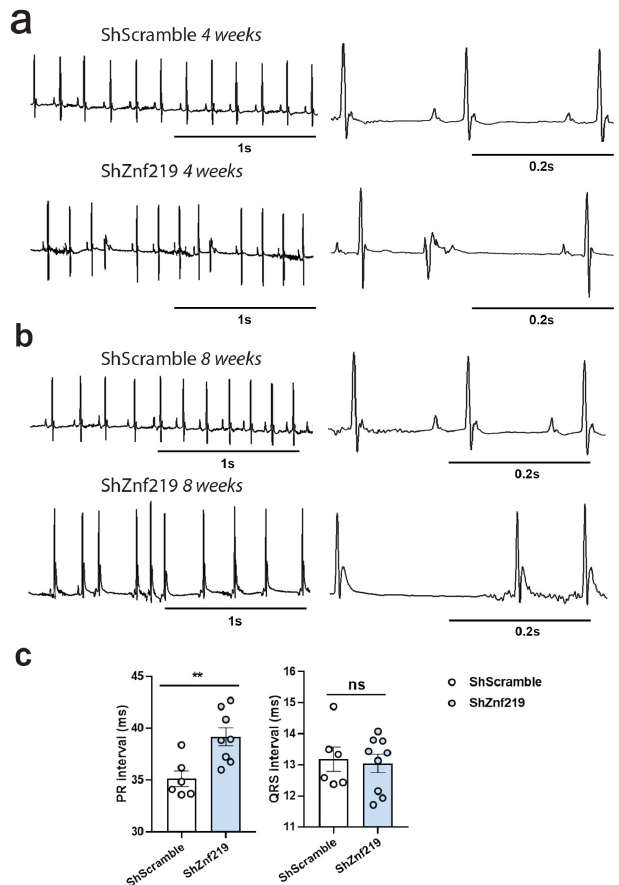
Figure 5. Znf219 knockdown induces cardiac arrhythmias . ( a ) Electrocardiography (ECG) traces of 4-week-old and ( b ) 8-week-old mice infected with shRNA-Scramble or shRNA- Znf219 , the latter showing arrhythmias ( c ). PR and QRS intervals in 4-week-old mice infected with shRNA-Scramble ( ShScramble ) or shRNA- Znf219 ( ShZnf219 )., ** p ≤ 0.01, (mean + S.E.M.), ns= non-significant.